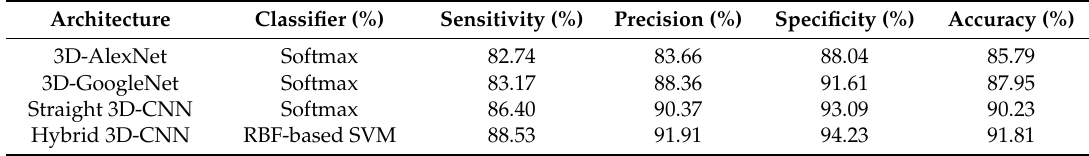
Table 4. Comparative results of the proposed and other used